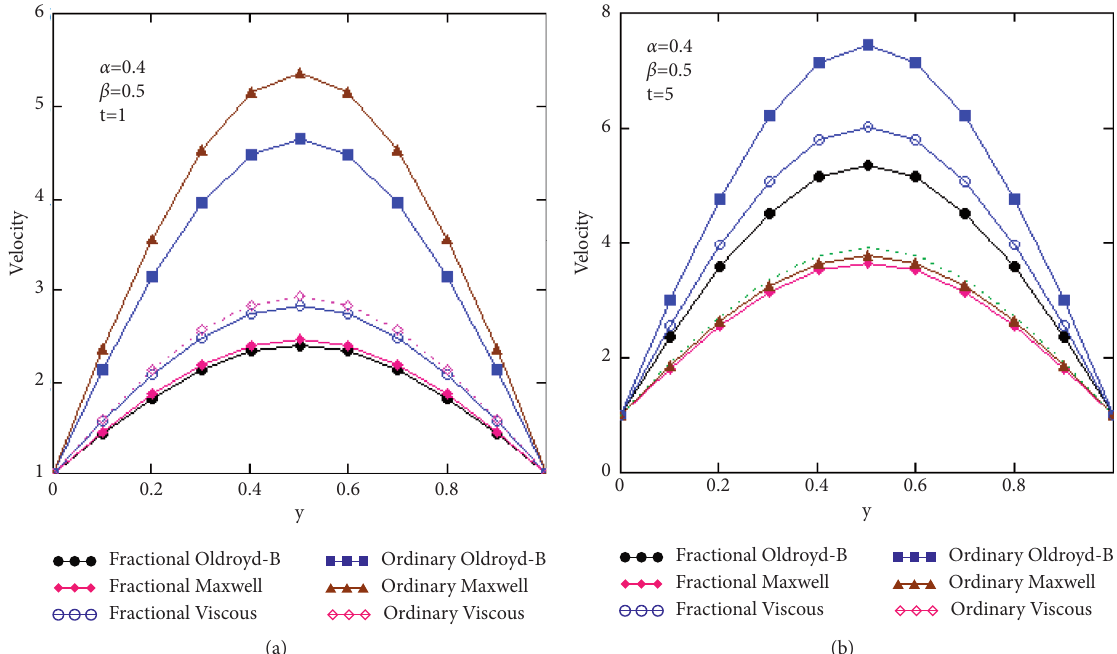
Figure 14: Comparisons between fractional Oldroy-B, ordinary Oldroyd-B, fractional Maxwell, ordinary Maxwell, fractional viscous, and ordinary viscous fluids at Gr � 5 , Pr � 20 , Q � 0 . 5, and f